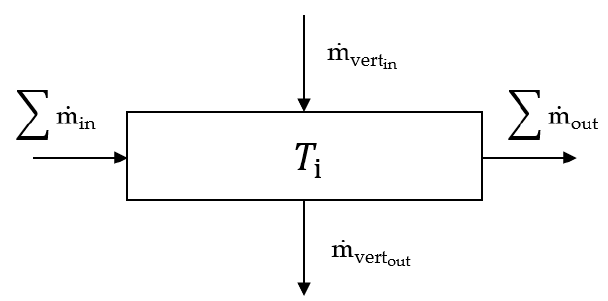
Figure 2. Generic node schematic representation.